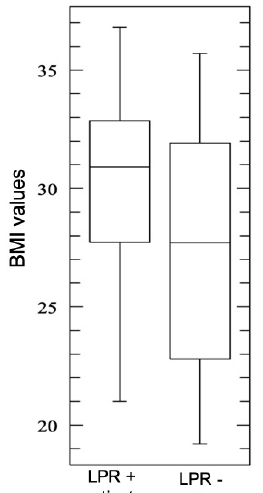
Figure 5. Box plot: Correlation between BMI (body max index) values of LPR (laryngopharyngeal reflux) + and LPR − patients.